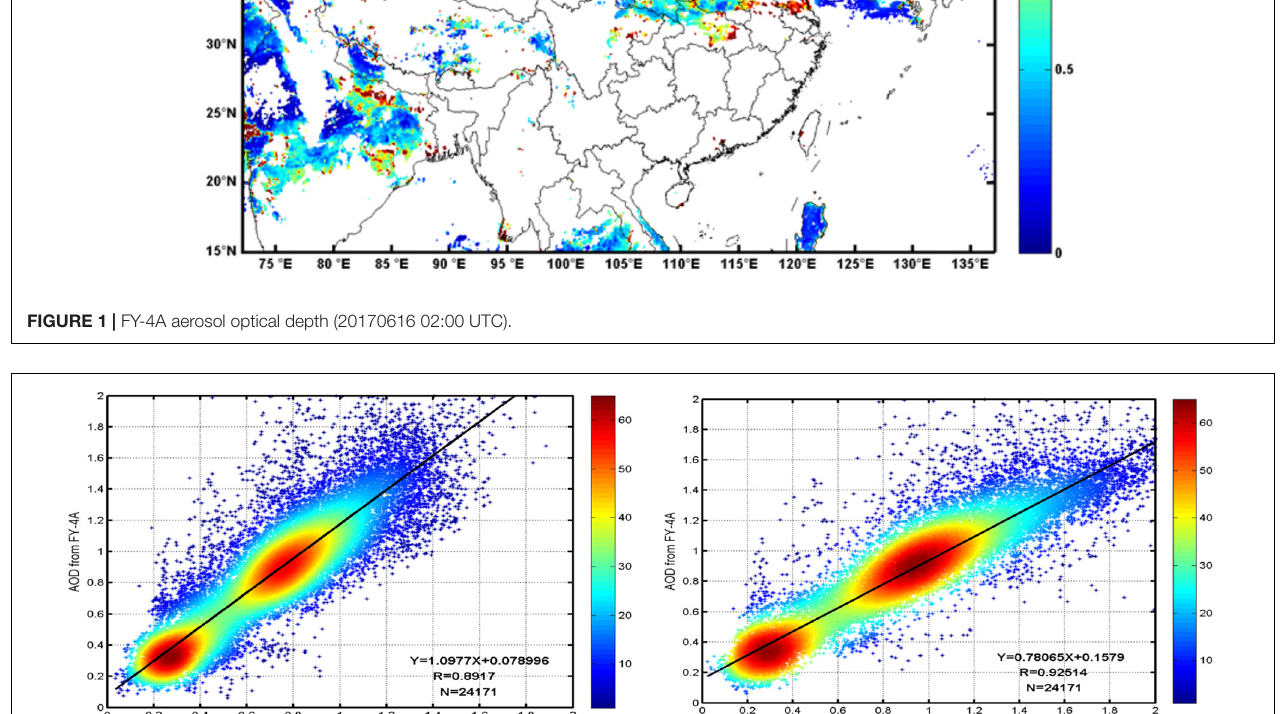
Frontiers in Earth Science |